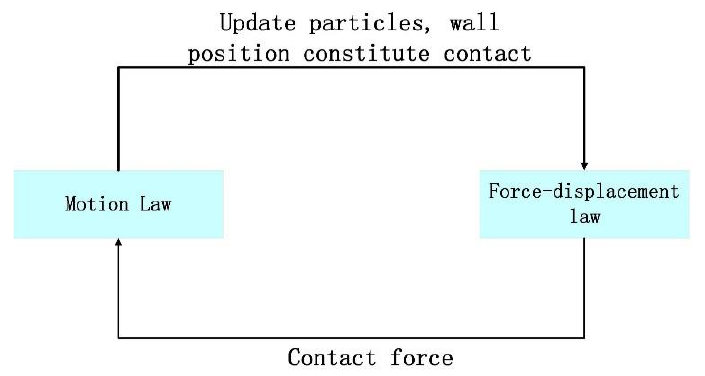
Figure 15. Cycle calculation process.